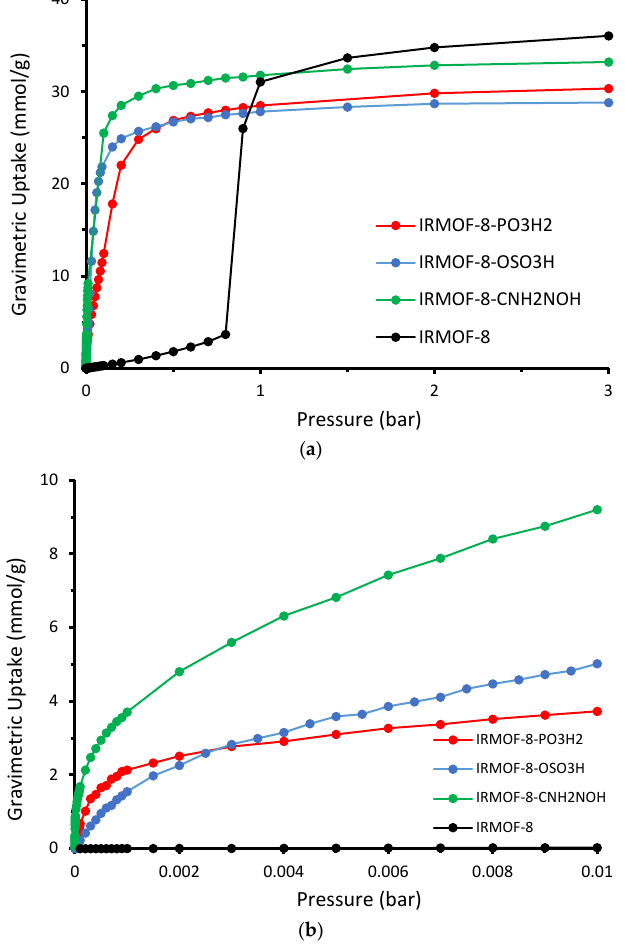
Figure 8. Absolute gravimetric isotherms for IRMOF–8 and IRMOF–8-n (n: –PO 3 H 2 , –OSO 3 H and –CNH 2 NOH) at T = 298 K and pressure range from ( a ) 3 bar to ( b ) 0.01 bar.